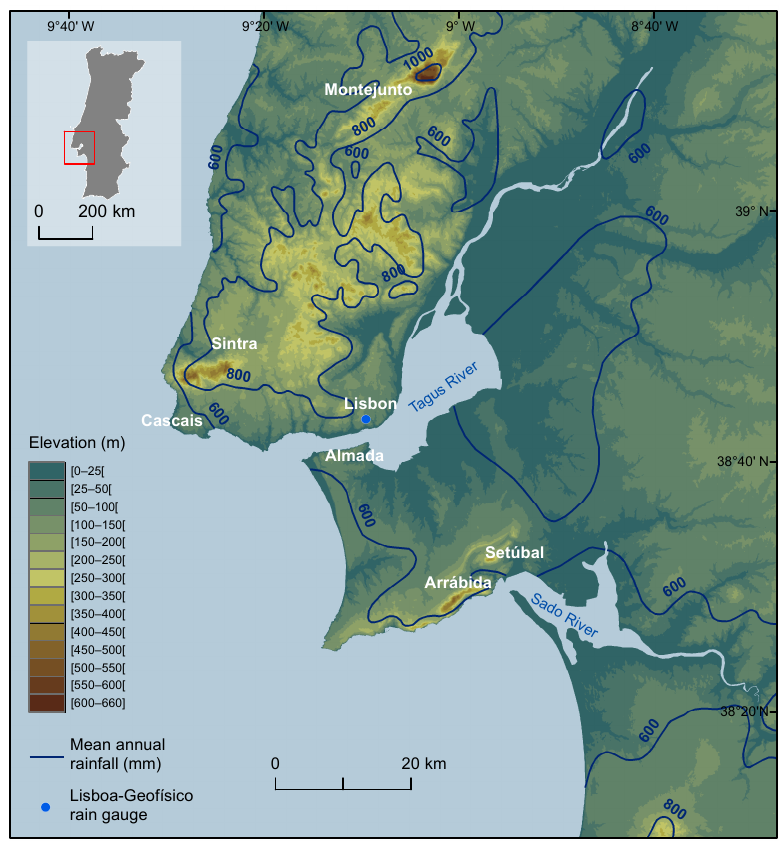
Figure 1. Elevation and mean annual rainfall in the study area (source: Daveau et al., 1977).